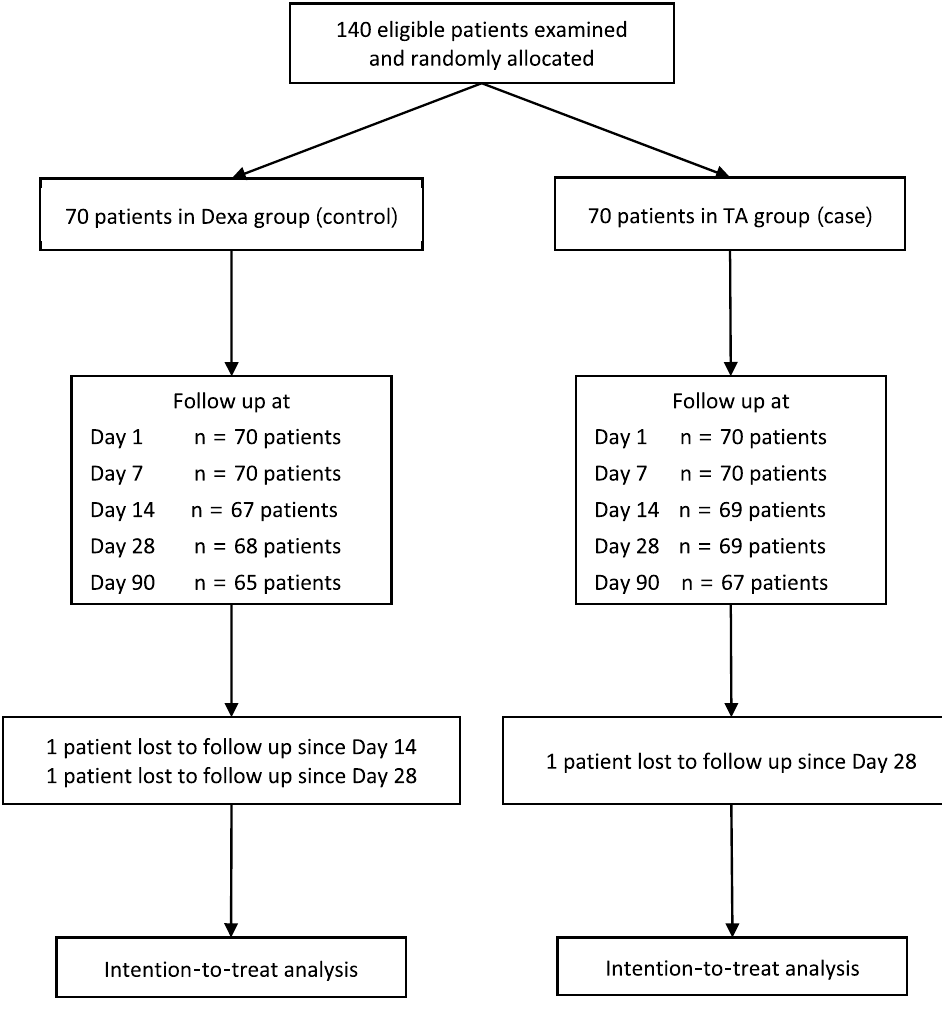
Figure 1. Flow diagram of patients through the